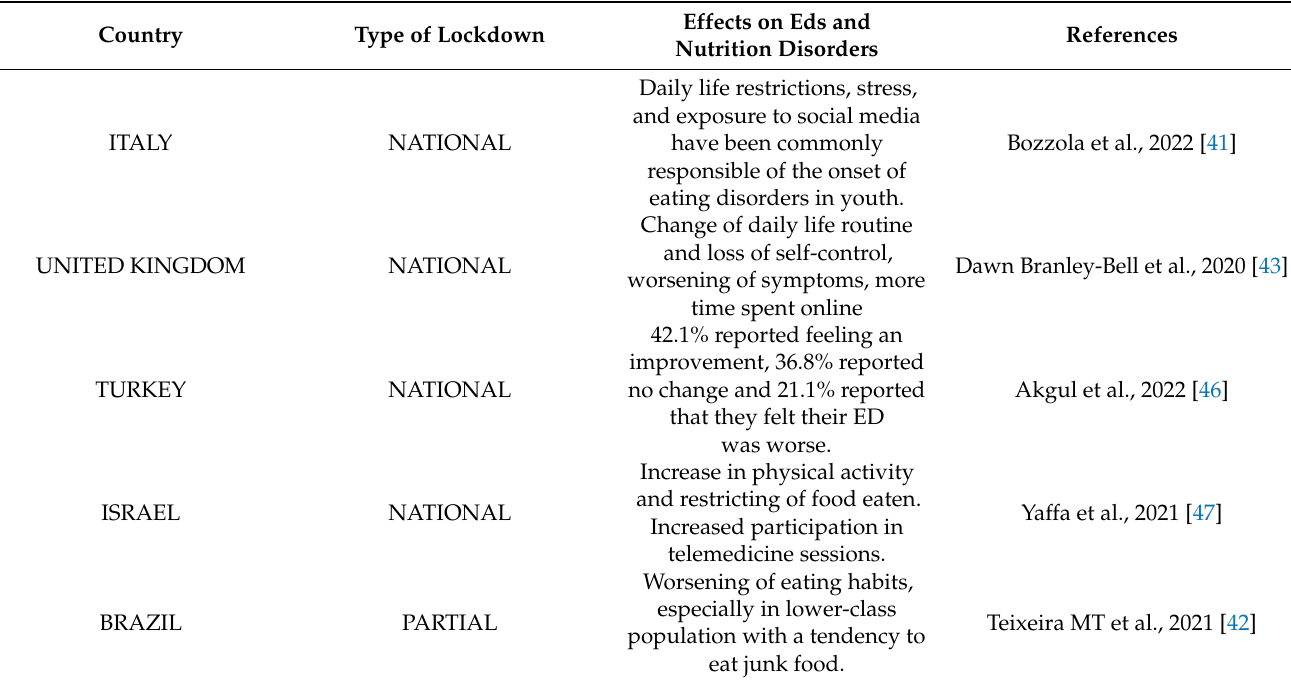
Table 2. The different types of lockdown and their effects on nutritional and metabolic diseases in various